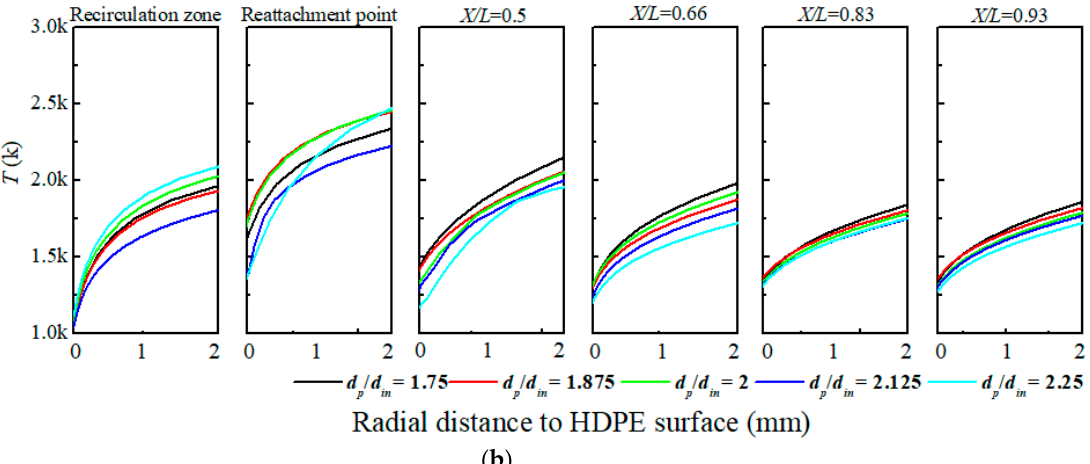
Figure 30. Temperature ( a ) and temperature around HDPE grain surface ( b ) at different axial positions of different cases.